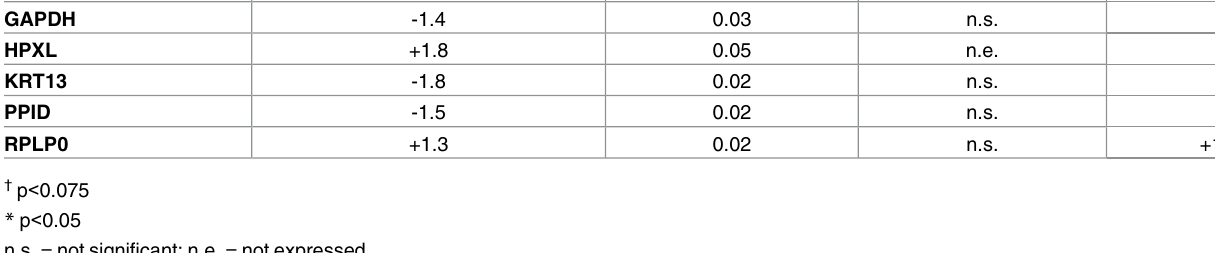
mucus of salmon fed unspecified prebiotic supplements [26]. The MASCOT search of the pep- tide sequences for spot 971 indicate that the protein in this experiment was more similar to peptidyl-prolyl cis-trans isomerase D (PPID), also known as cyclophilin D which is involved